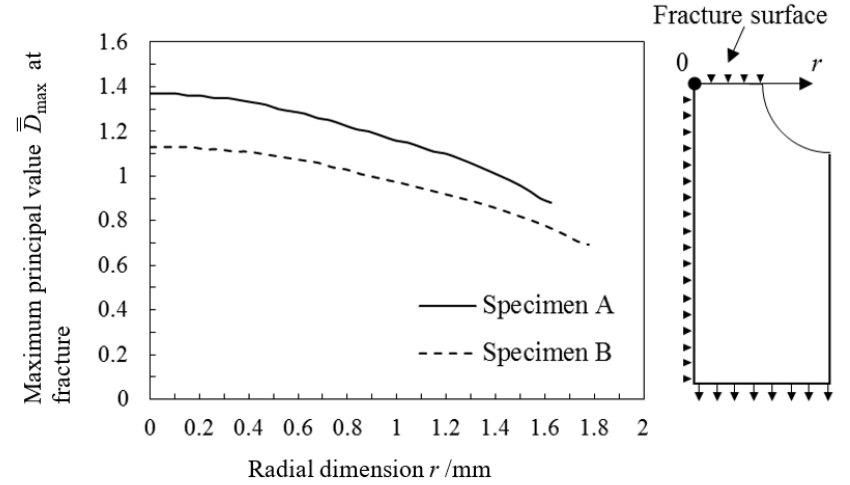
Figure 11. Change in the maximum principal damage values to the radial dimension at fracture surface of notched round specimens (No. 4 and No. 9 in Table 2).